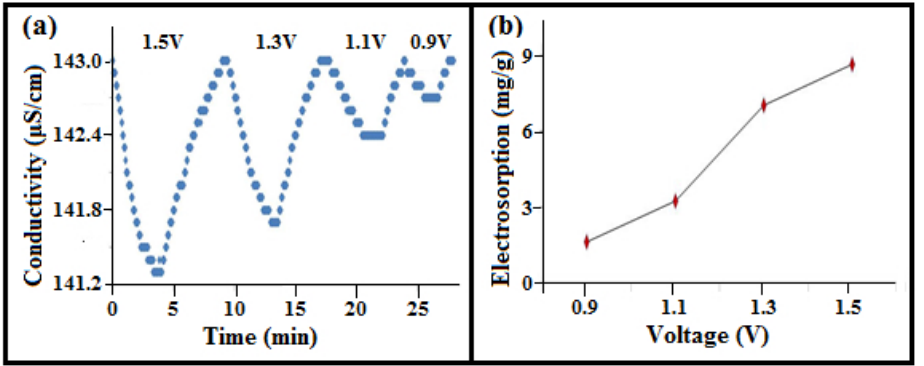
Figure 3. ( a ) Conductivity variations of NaCl solution in the adsorption and release time for 3.52 wt% a-SWCNT-coated RVC electrodes at a flow-rate of 25 mL/min with various applied voltages and operating times; and ( b ) electrosorption as a function of applied